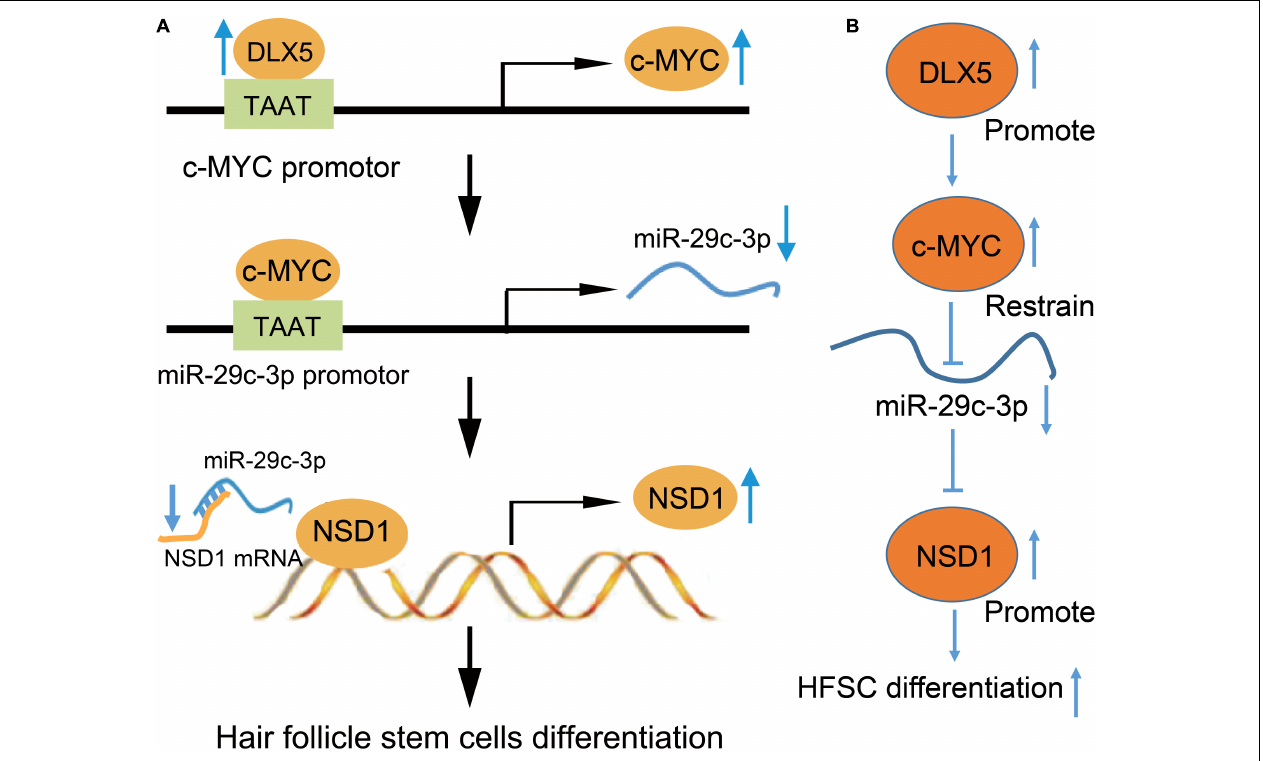
FIGURE 8 | Mechanistic diagrams. (A) DLX5 binds to the promoter region of c-MYC, leading to c-MYC transcriptional activation to increase its expression. The increased expression of c-MYC enhances the binding of c-MYC in the promoter region of miR-29c-3p, which inhibits the transcription of miR-29c-3p. The decreased expression of miR-29c-3p weakened the inhibitory effect of miR-29c-3p on NSD1-mRNA. Therefore, the increased expression of NSD1 promotes the differentiation of HFSCs. (B) DLX5 promotes the transcription of c-MYC and c-MYC restrains the transcription of miR-29c-3p. The downregulated expression of miR-29c-3p reduced the inhibition of miR-29c-3p on NSD1-mRNA. Therefore, the increased expression of NSD1 promotes the differentiation of HFSCs. Therefore, our results showed the promoting effect of the DLX5/c-MYC/miR-29c-3p/NSD1 axis on HFSC differentiation, that DLX5 promotes the transcriptional expression of c-MYC to inhibit the expression of miR-29c-3p, thus reducing the inhibitory effect of miR-29c-3p on NSD1. Considering that NSD1 promotes HFSC differentiation, DLX5 increases the expression of NSD1 to promote HFSC differentiation.